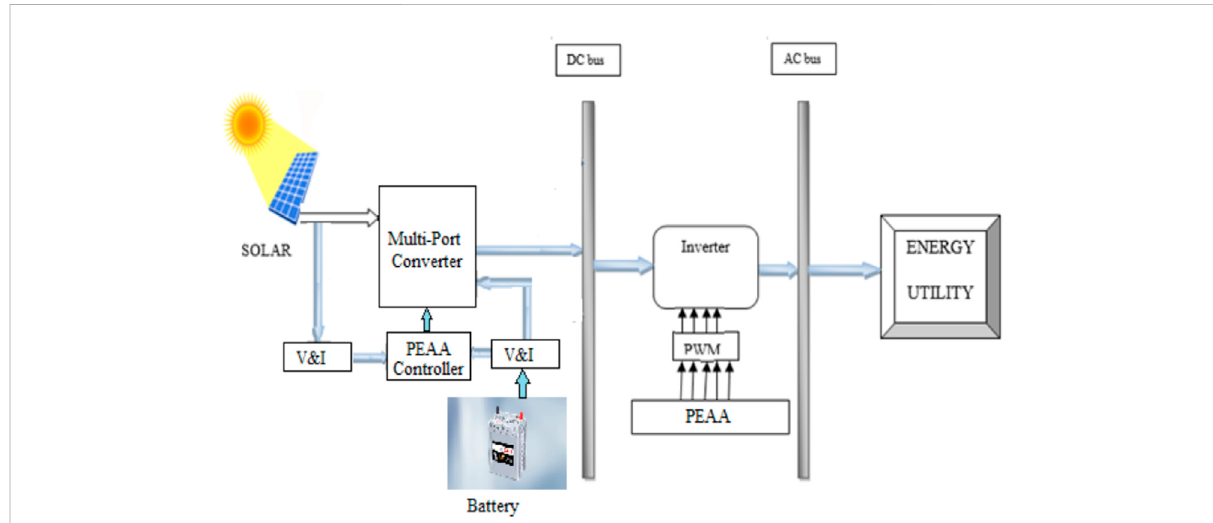
FIGURE 2 Proposed Multi-port converter using Predictive Energy Amendment Algorithm.